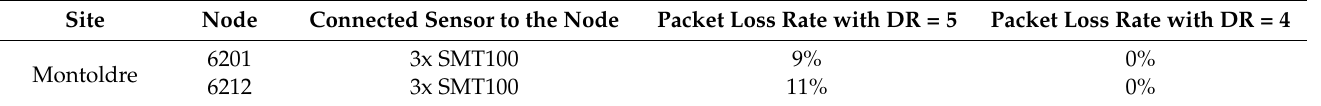
Table 4. Comparison of packet loss rate depending on DR setting.